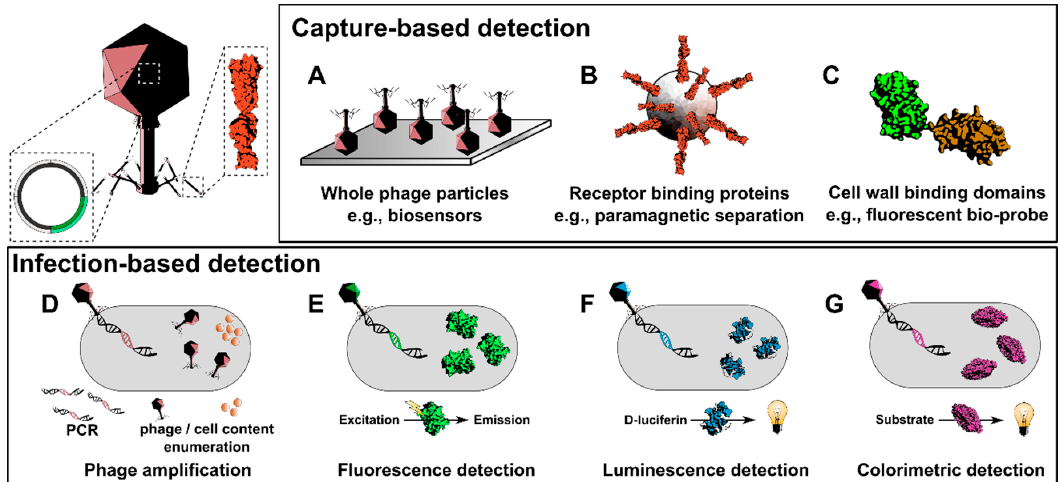
Figure 1. Overview of phage-based pathogen detection. Capture-based detection: The limited host ranges of phages towards a given genus, species or subspecies of bacteria make them ideal candidates for development into detection bio-probes. ( A ) The high binding affinity of whole-phage particles has led to their use as bio-probes in biosensors [28–30], or by conjugation with radioactive tracers [43] fluorophores [44], magnetic nanoparticles [31,45] or a combination of both [46] to label and enrich bacteria for detection. ( B ) Host specificity of phages is mediated by specialized receptor-binding proteins (RBPs) that provide equivalent binding capabilities as whole phages, but at a fraction of the size. Recently, RBPs have been applied in biosensors [47], ELISA-based assays [38,40], and for glycotyping Salmonella [39] and Listeria [32]. ( C ) Alternatively, cell wall-binding domains (CBDs) of phage endolysins have proven highly e ff ective at detecting Gram-positive pathogens. CBDs